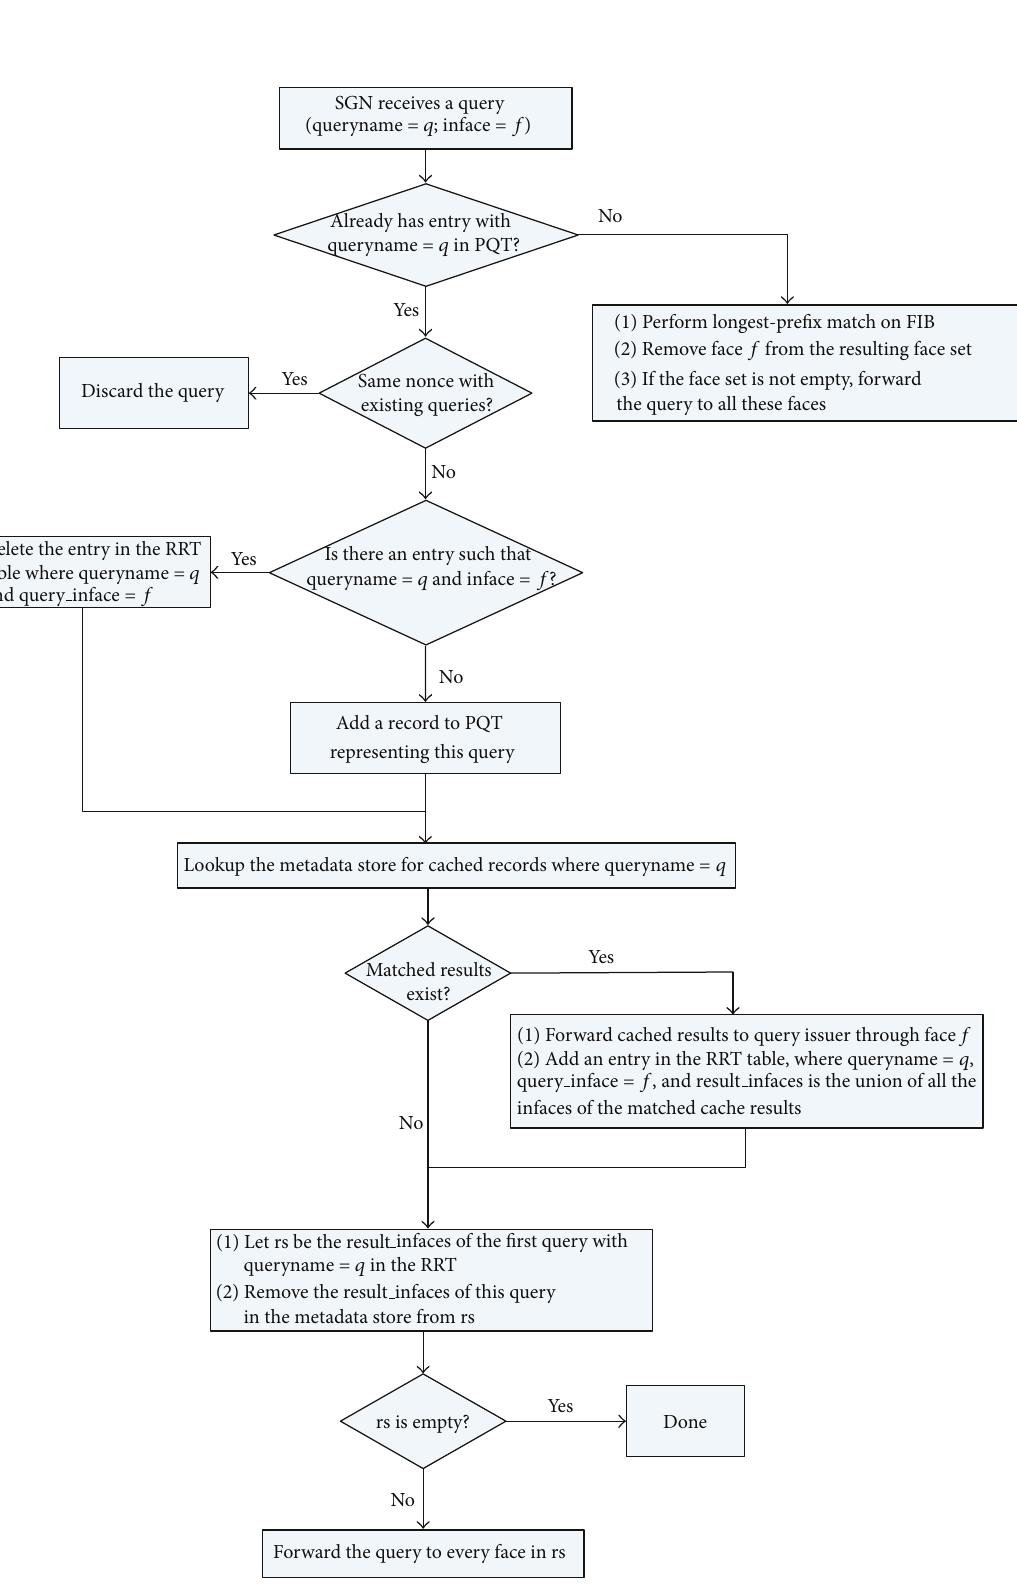
Figure 3: Query process